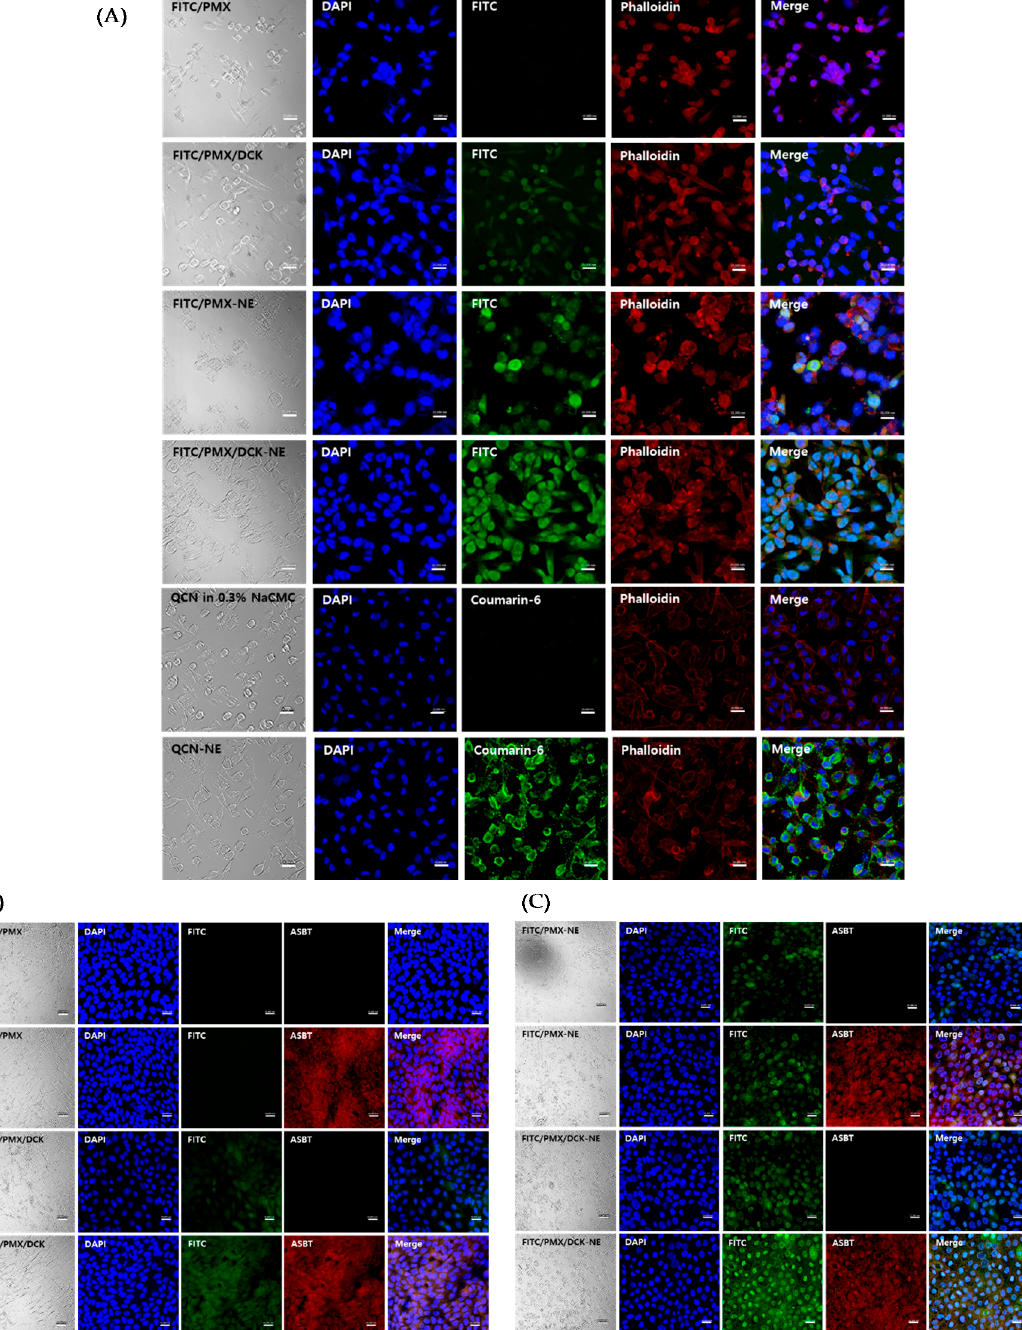
Figure 4. Confocal laser scanning microscopy images of the cellular uptake of ( A ) fluorescein isothiocyanate (FITC)-PMX, FITC-PMX/DCK, FITC-PMX-NE, FITC-PMX/DCK-NE, QCN in 0.3% NaCMC, and QCN-NE in Caco-2 cells; ( B ) FITC-PMX and FITC-PMX/DCK in MDCK or ASBT-transfected MDCK cells; and ( C ) FITC-PMX-NE and FITC-PMX/DCK-NE in MDCK or ASBT-transfected MDCK cells. Scale bar represents 20 µm.